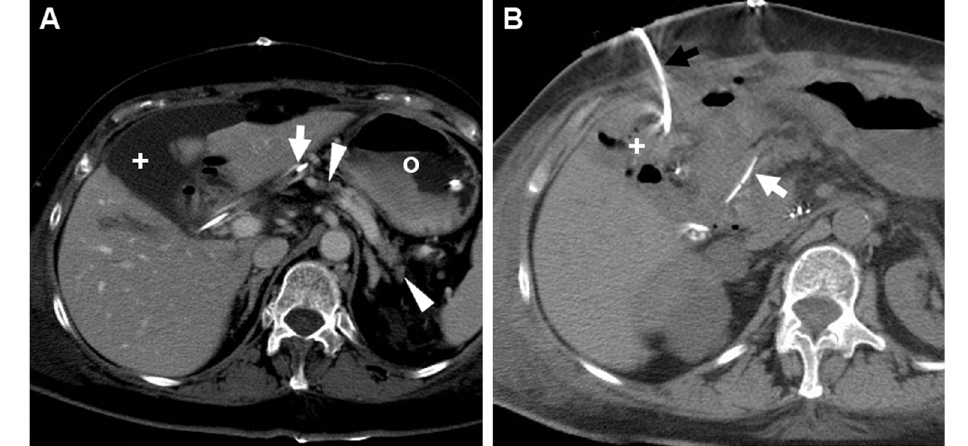
Fig. 8 Bile collection found 4 days after PD for distal common bile duct (CBD) cholangiocarcinoma in an 83-year-old woman with biliary leakage from the laparotomic incision site. Contrast-enhanced CT ( a ) showed distended stomach (o) consistent with DGE, external drainage